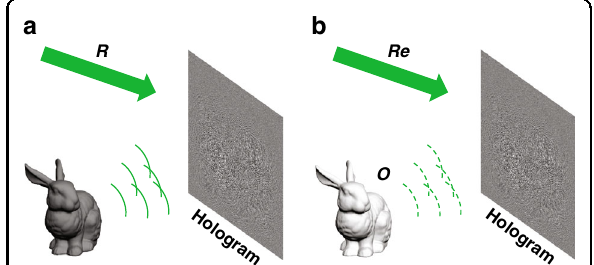
Fig. 1 The schematic of hologram recording and reconstruction process. a Recording; b reconstruction.